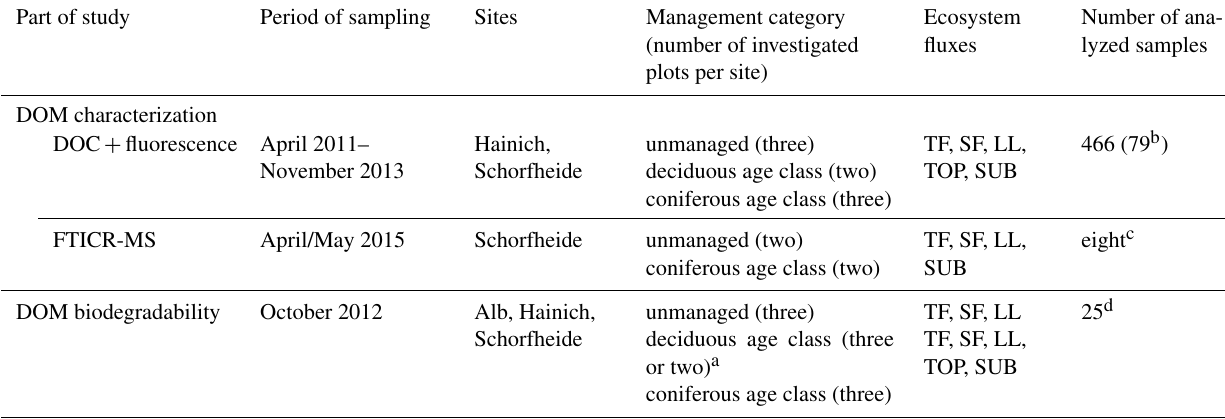
Table 2. Overview of the samples used for the various analytical procedures. TF: throughfall; SF: stemflow; LL: litter leachate; TOP: topsoil solution; SUB: subsoil